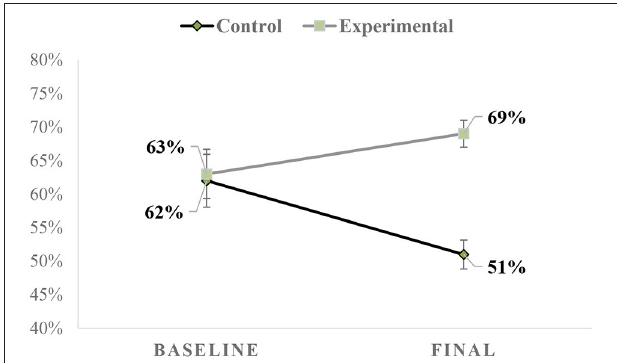
FIGURE 1 | Mean scores for free throw shooting performance (percentage) at baseline and final assessment.